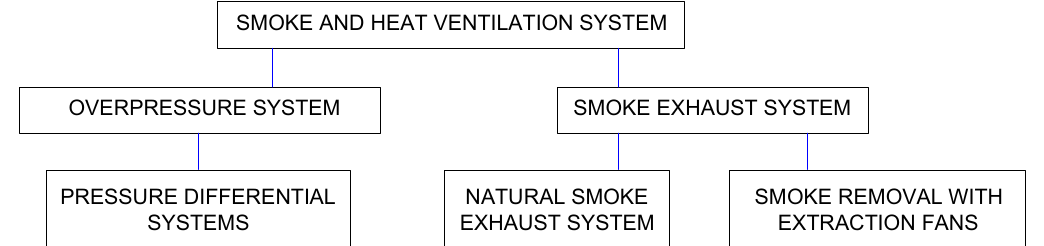
Figure 1. Solutions of smoke and heat ventilation systems for a staircase.